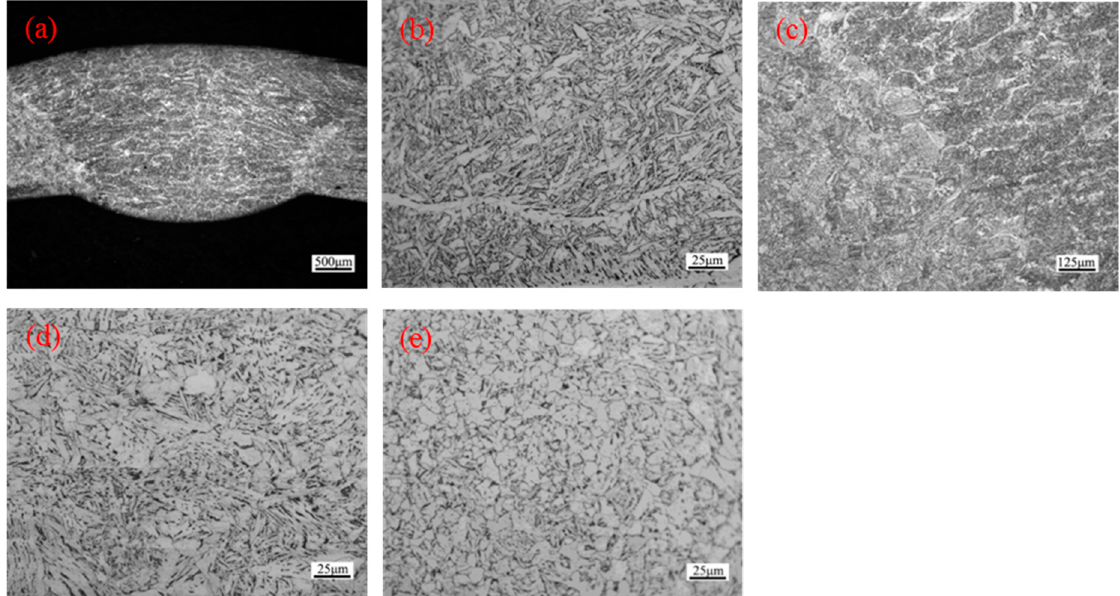
Figure 7. Micro-structure of electric water heater tank longitudinal weld: ( a ) weld zone ( b ) Columnar grain zone in the middle of weld ( c ) Fusion zone ( d ) Heat affected zone (superheated zone) ( e ) Heat affected zone (normalized zone).